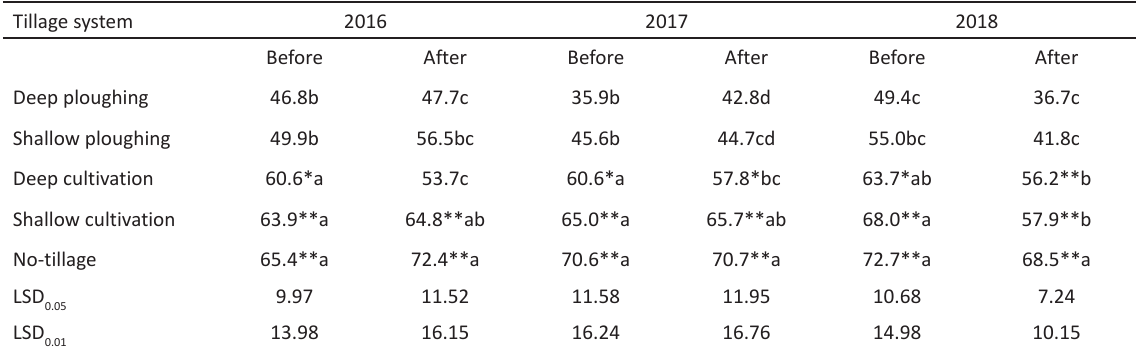
Table 5. Effects of different tillage practice on soil aggregate stability to water (SAS, %) (0–15 cm layer) before and after faba bean vegetative growth period Tillage system After Before After Before